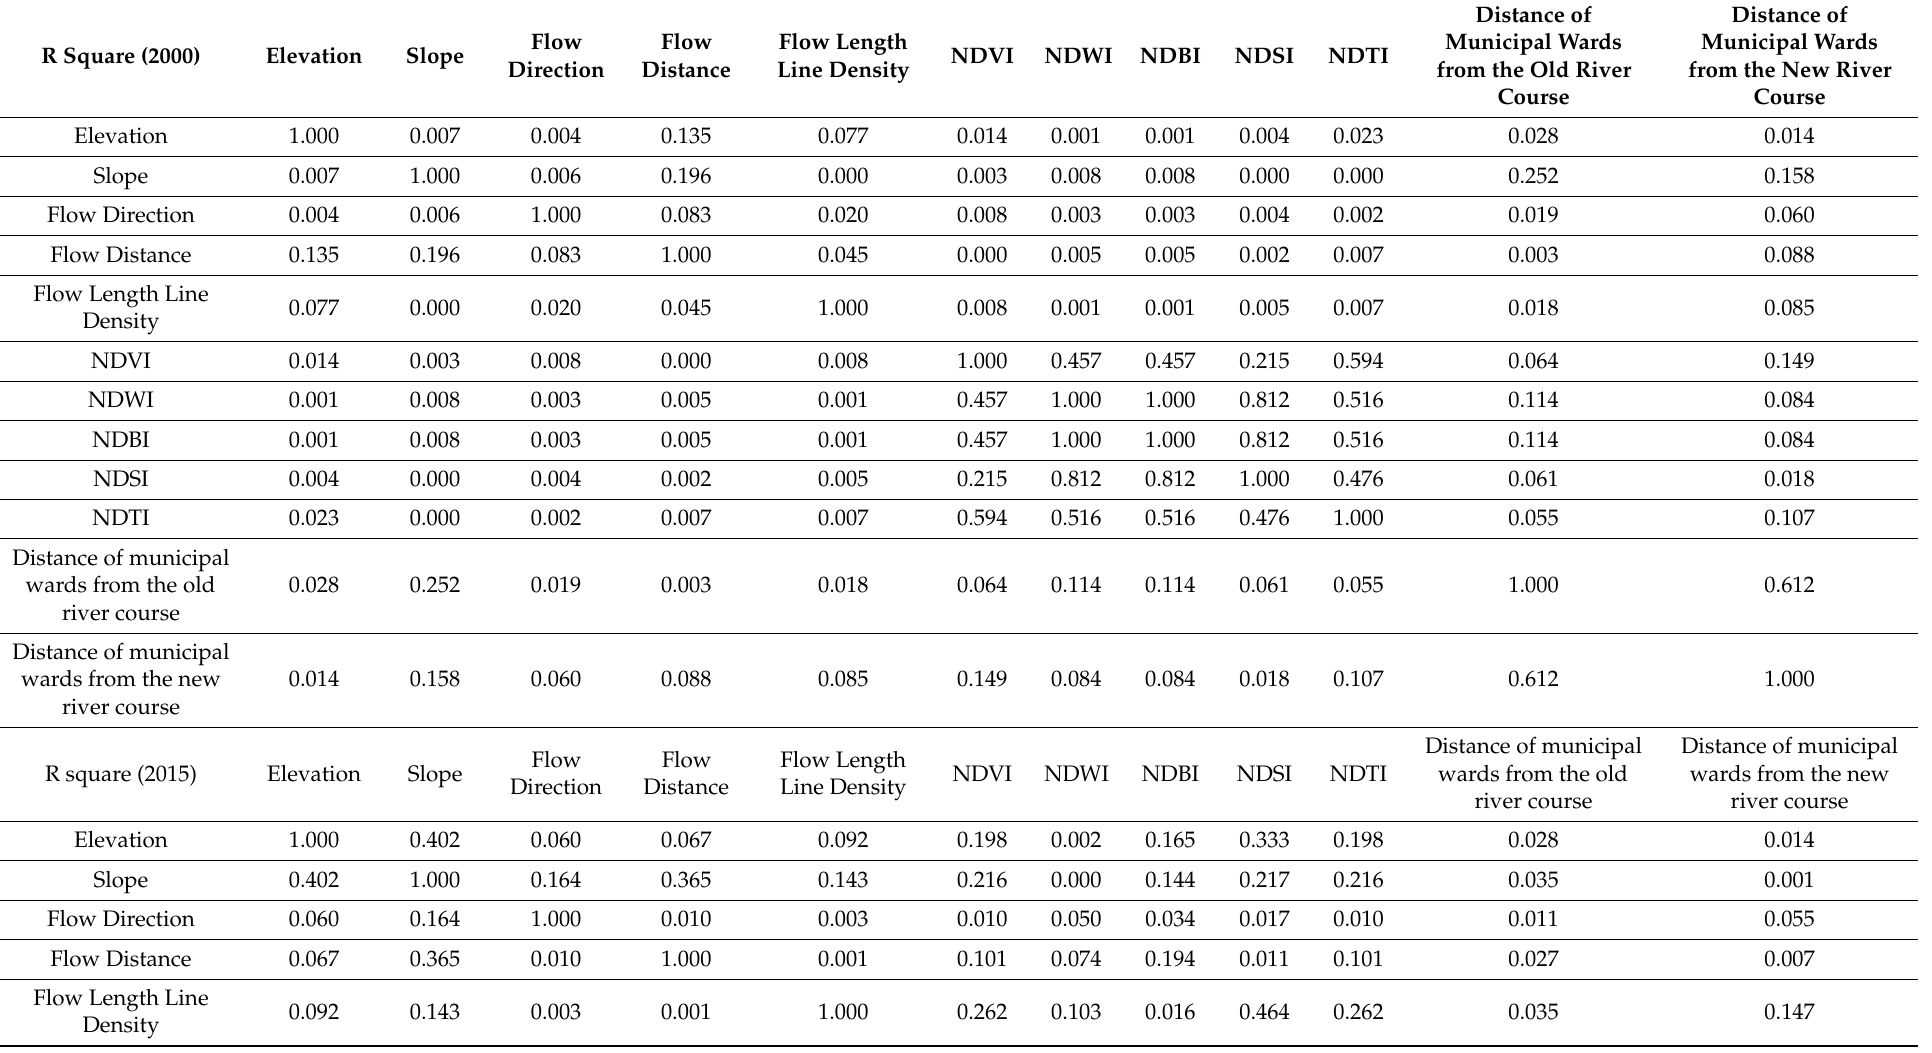
Table 12. Coefficient of determinants (assigned weights of MCDM) of the selected indicators of flood vulnerability (2000 and 2015).